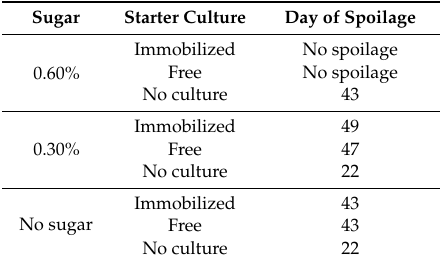
Table 1. E ff ect of sugar addition and probiotic starter culture on shelf-life of dry-fermented sausages. Spoilage was defined as the point when 50% of the panellists rejected the sausage samples (spoilage was monitored up to 66